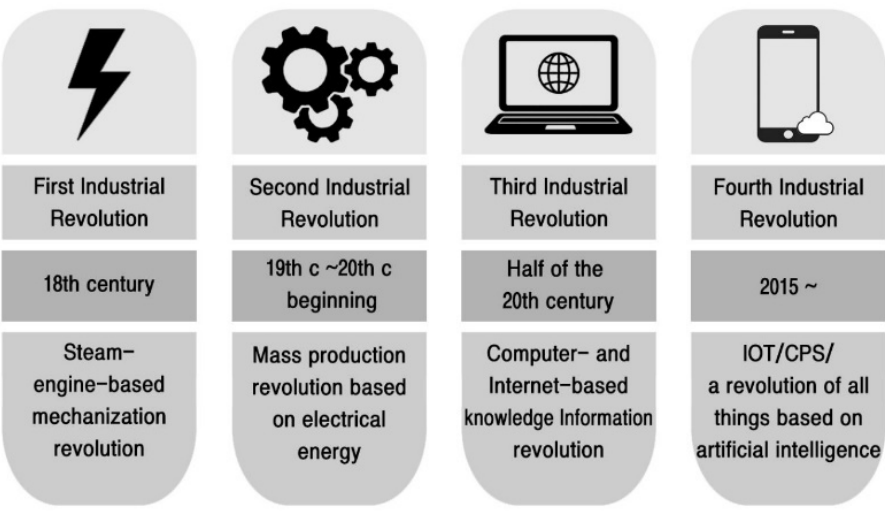
Figure 8. Outline of the industrial revolutions.